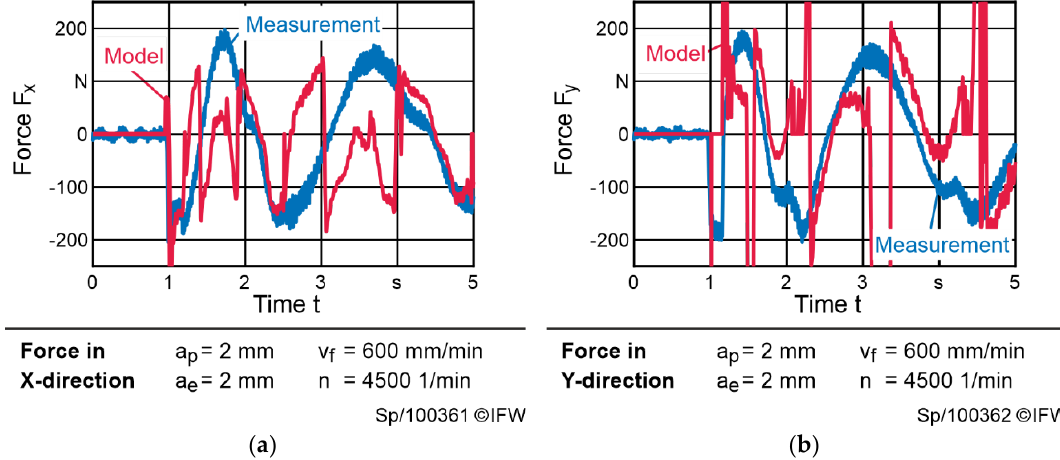
Figure 6. Comparison between measured process forces and the model-based approach during milling of a circular pocket: ( a ) force acting in X -direction (RMSE = 104.4 N); ( b ) force acting in Y -direction (RMSE = 149.1 N).